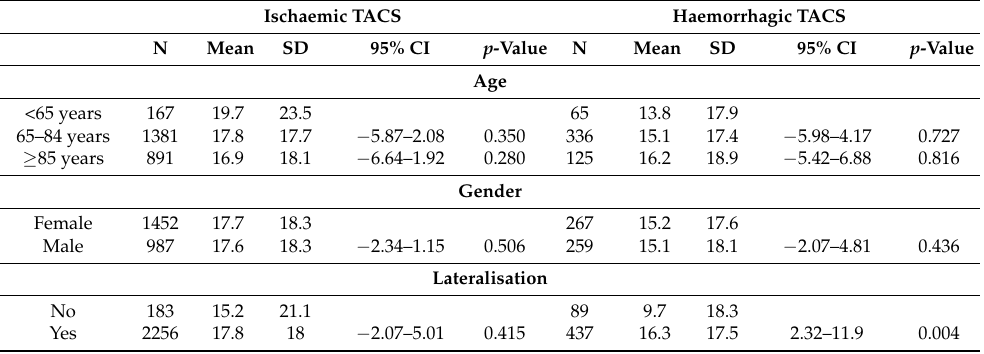
Table 2. Adjusted combined length of stay analysis with 95% confidence intervals of ischaemic and haemorrhagic TACS. Ischaemic TACS Haemorrhagic